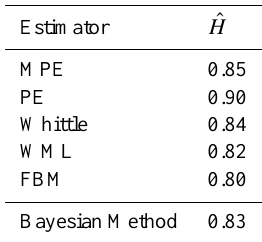
Table 3. Estimation of the Hurst exponent for different